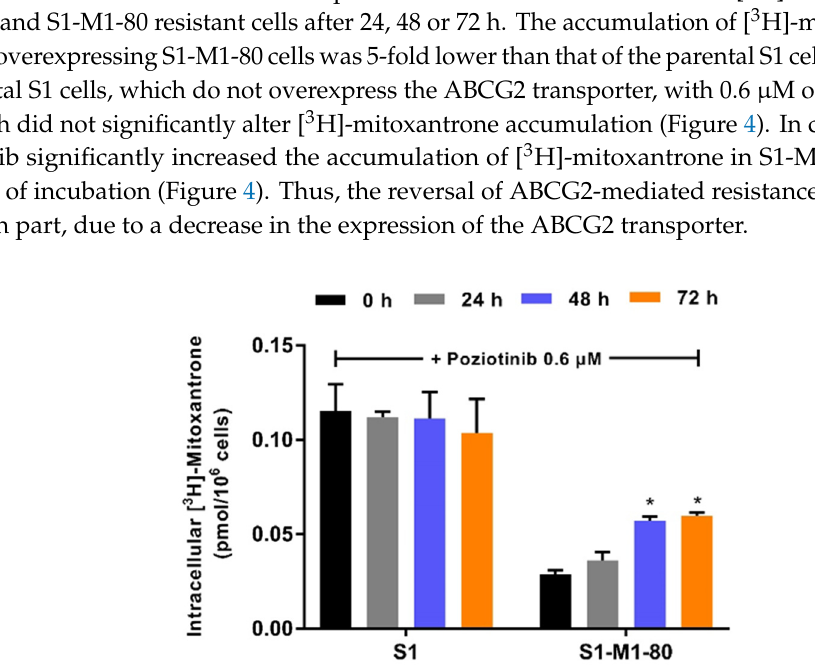
Figure 4. The effect of poziotinib on [ 3 H]-mitoxantrone accumulation in S1 and S1-M1-80 colon cancer cells. The intracellular accumulation of [ 3 H]-mitoxantrone was determined in S1 and S1-M1-80 colon cancer cells after incubation with 0.6 μ M of poziotinib for 0, 24, 48 or 72 h. Data are expressed as mean ±SD derived from three independent experiments. * p < 0.05 versus the control group.